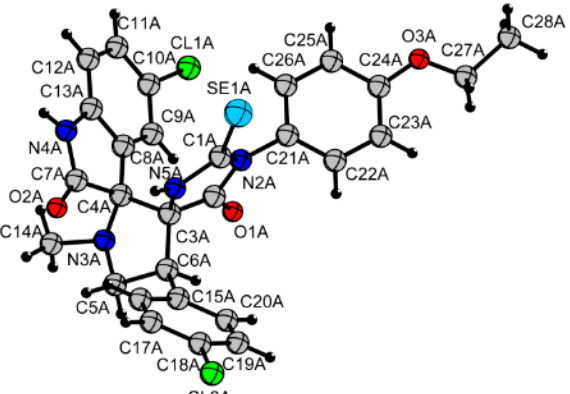
Figure 2. Molecular structure of compound 5b (CCDC 1999058; one crystallographically independent molecule is shown; the designations of the second independent molecule in the Supplementary Information are similar (NN_B)).